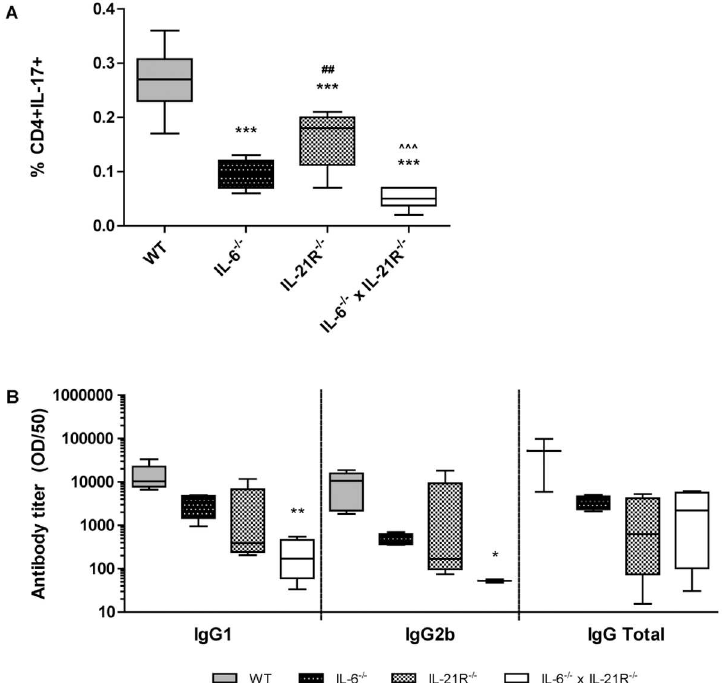
Fig 2. IL-6 and IL-21 play an important role during in vivo Th17 differentiation and antibody production. AIA was inducedin WT, IL-6 -/- , IL-21R -/- , and IL-6 -/- x IL-21R -/- mice. Draininglymph node CD4 +IL-17+ cell fraction two days after arthritis inductionas measuredusing flow cytometry (A; n = 10/group). Serum IgG1, IgG2b, and total IgG levels as measuredby ELISA (B; n = 5/group). * p < 0.05, ** p < 0.01, *** p < 0.001versus WT; ## p < 0.01versus IL-6 -/- ; ^^^p < 0.001versus IL-21R -/- ; A—One-way ANOVA, B—